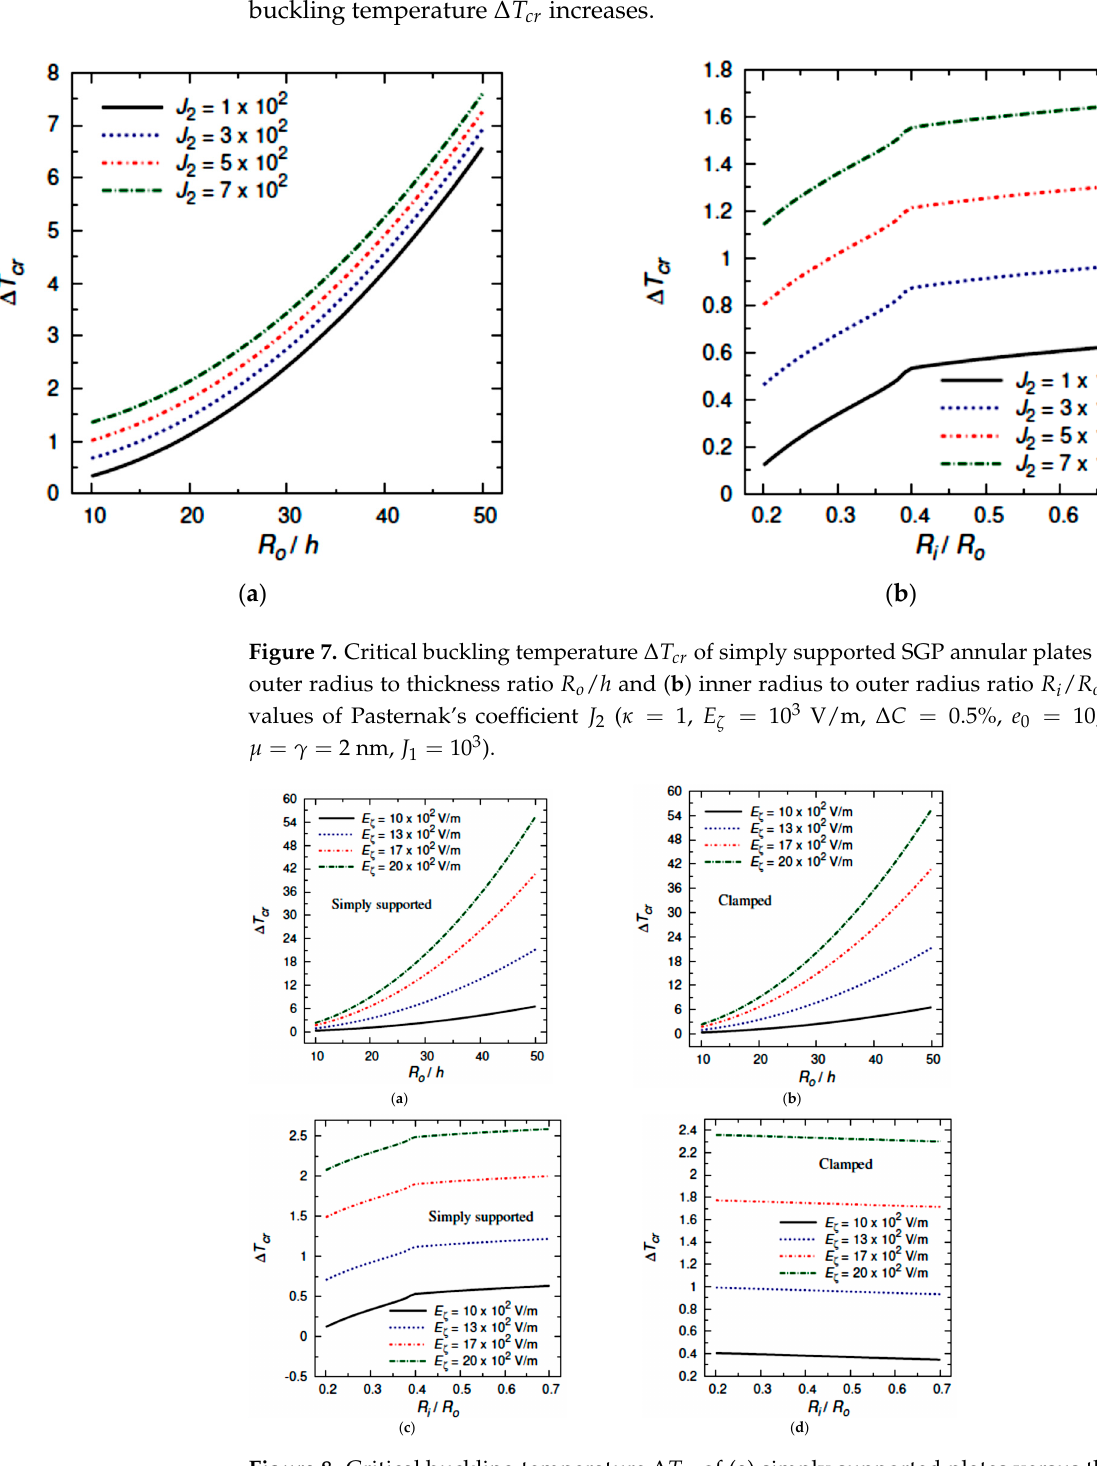
Figure 9. Effects of the piezoelectric multiple 𝑒 (cid:2868) on the critical buckling temperature Δ𝑇 (cid:3030)(cid:3045) of simply supported SGP annular plates for different values of electric field 𝐸 (cid:3085) ( 𝑅 (cid:3042) /ℎ = 10 , 𝑅 (cid:3036) /𝑅 (cid:3042) = 0.3 , 𝜅 = 1 , Δ𝐶 = 0.5% , 𝑤 (cid:3034) = 0.1% , 𝐽 (cid:2869) = 10 (cid:2871) , 𝐽 (cid:2870) = 10 (cid:2870) ). Figure 10a,b show a monotonic decrease in the critical buckling temperature Δ𝑇 (cid:3030)(cid:3045) as the strain gradient coefficient 𝛾 increases for simply supported and clamped SGP annular plates. Moreover, it is noticed that for the same value of strain gradient coefficient 𝛾 , increasing the nonlocal coefficient 𝜇 tends to decrease for simply supported SGP annular plates and increase for the case of clamped SGP annular plates.